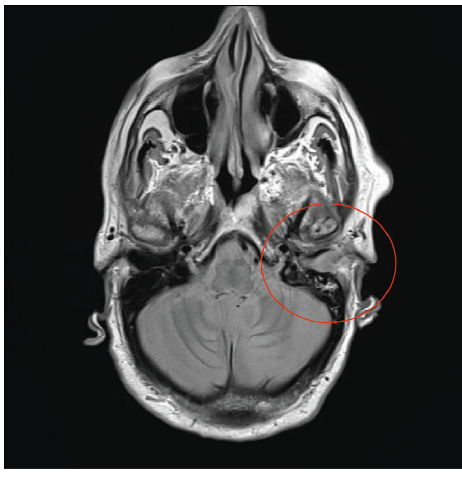
Figure 2: Brain MRI without and with contrast